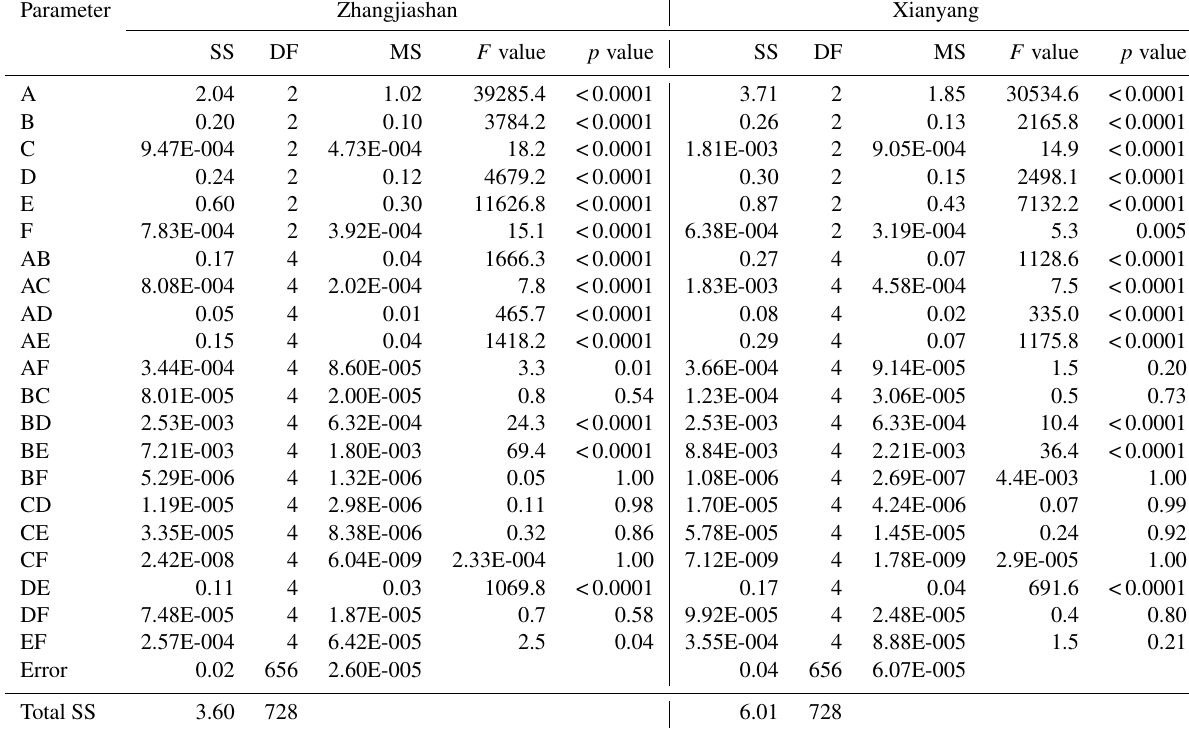
Table 5. ANOVA table for failure probability in OR: A indicates the shape parameter in GEV, B indicates the scale parameter of GEV, C indicates the location parameter of GEV, D means the meanlog of LN, E means the sdlog of LN, and F means the parameter (i.e. theta) in